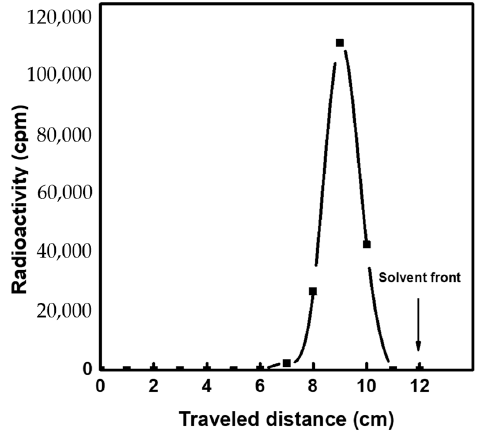
Figure 7. Radiochromatogram of the eluted 99m Tc. Since 99 Mo is the prime impurity that may interfere with the eluate, determining its impurity level is a priority. The eluate purity was evaluated using gamma-ray spectrometry (HPGe detector coupled with a multichannel analyzer). The 99m Tc eluate was analyzed immediately after elution and after 60 h from elution, respectively. We observed that no energy peaks corresponding to 99 Mo were detected, and only the energy peak of 99m Tc (140 keV) was detected in the eluates. The absence of any 99 Mo gamma-energy peak in the collected samples indicated that the 99m Tc was obtained in an adequately pure form. The analysis of the decayed samples of 99m Tc verified that the 99 Mo breakthrough in the eluate was ≤ 0.1%. Furthermore, the decay curve of 99m Tc eluate was investigated, and the data show that the eluate decays with a half-life of ≈ 6 h, which verifies the high purity of the 99m Tc eluate